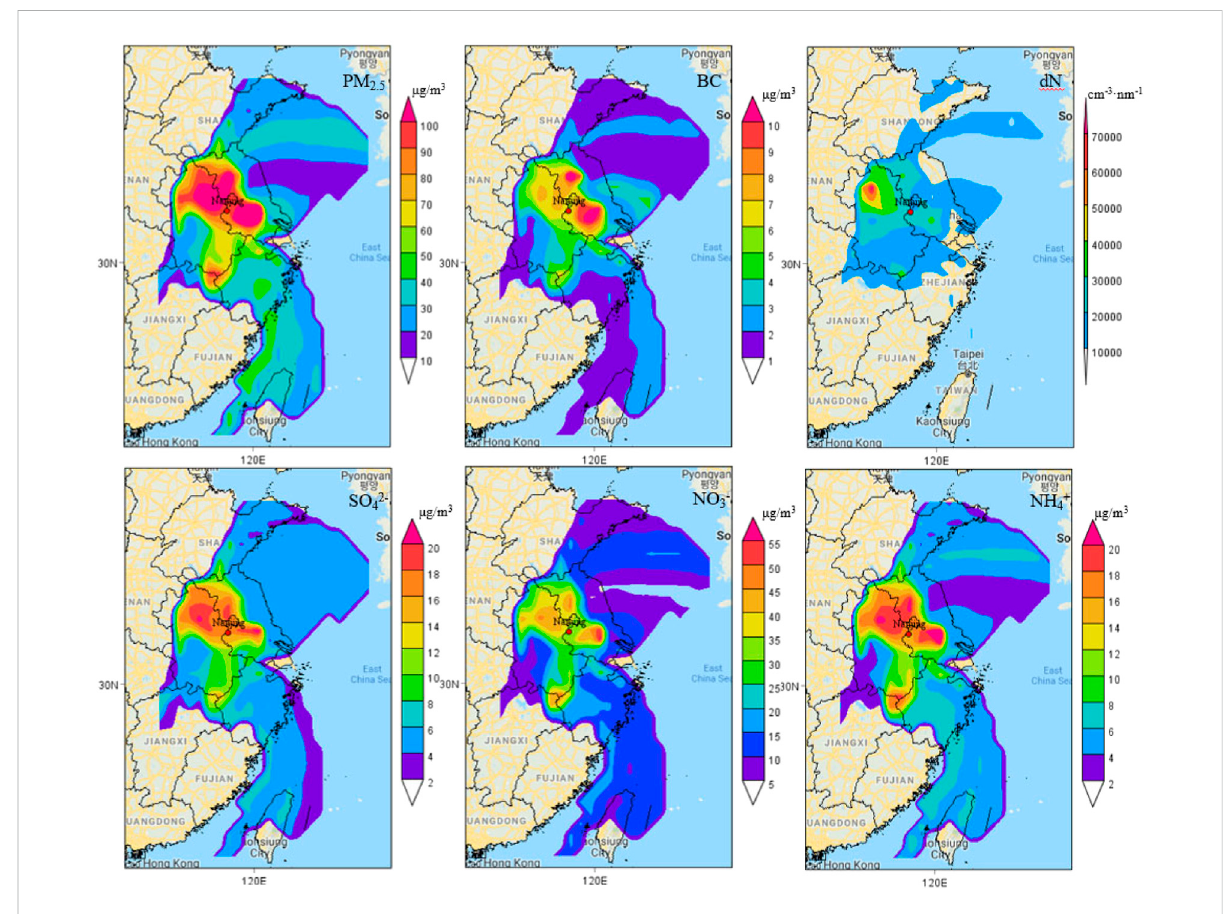
FIGURE 8 The CWT analysis of major pollutants with forward trajectory during the